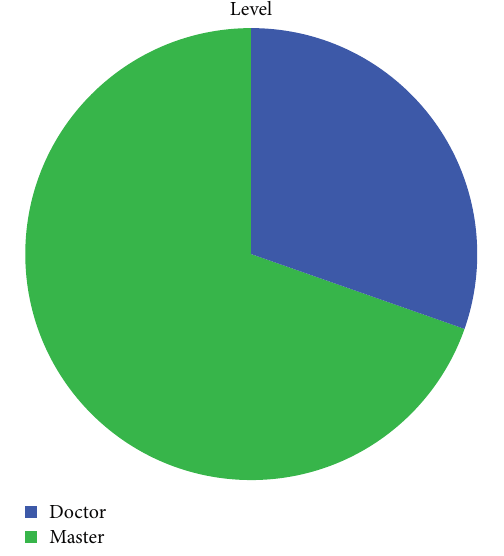
F IGURE 1: The proportion of doctoral and postgraduate students in the sample.